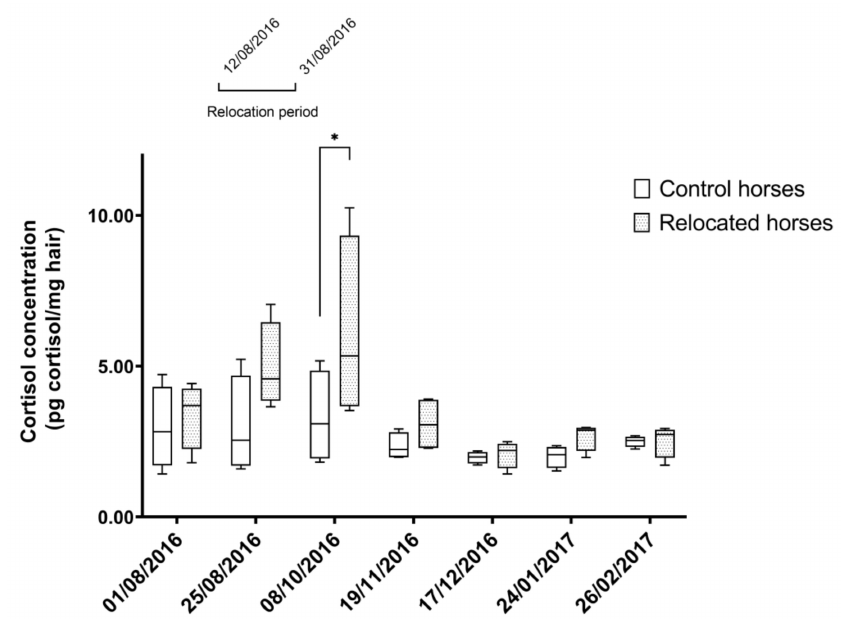
Figure 1. Hair cortisol concentrations in control and relocated horses during the study period. Hair cortisol concentrations (HCCs) (pg cortisol / mg hair) in control horses (N = 4, n = 28) and HCCs (pg cortisol / mg hair) in relocated horses (N = 4, n = 28) over the time of the study. Relocation period took place between 12th of August 2016 and 31st of August 2016. Asterisks represent significant di ff erences between groups ( p < 0.05). Median (25% percentile, 75% percentile). N = number of horses per group; n = number of determinations of HCCs.